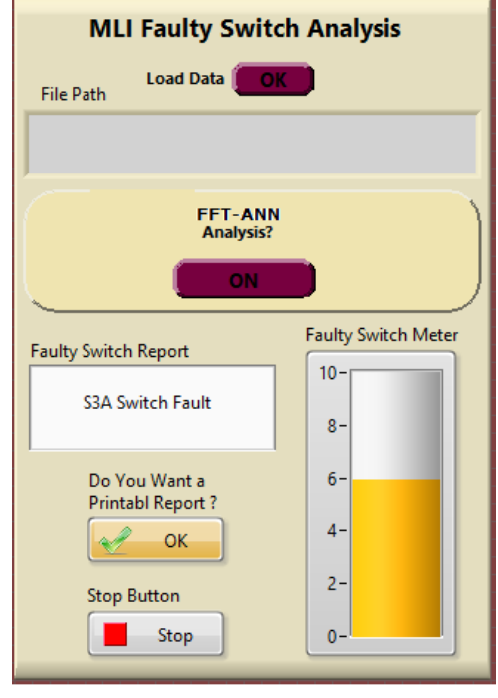
Figure 20. The front panel of MLI faulty switch analysis.